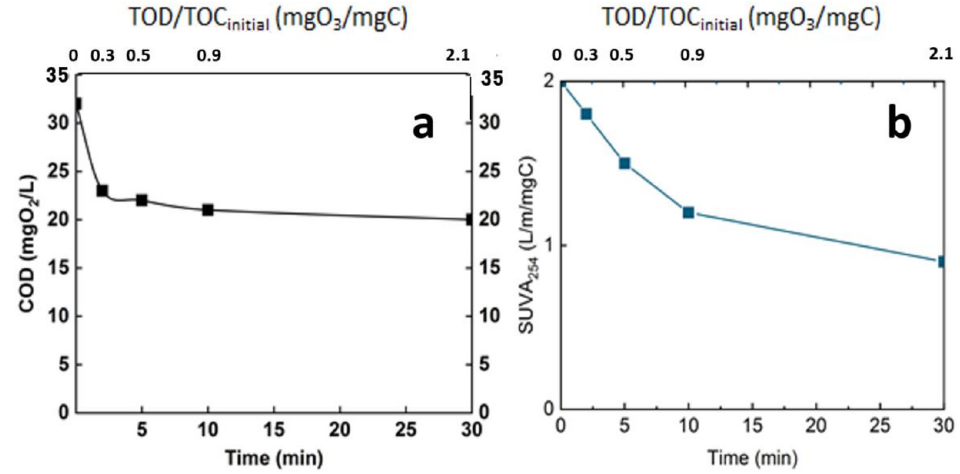
Figure 8. Evolution of global parameters of the real matrix during ozonation. ( a ): COD, ( b ): SUVA254, T ◦ = 20 ◦ C, Vreactor = 3 L, Vstir = 400 rpm, [O 3 ]gas = 5 gO 3 /Nm 3 .